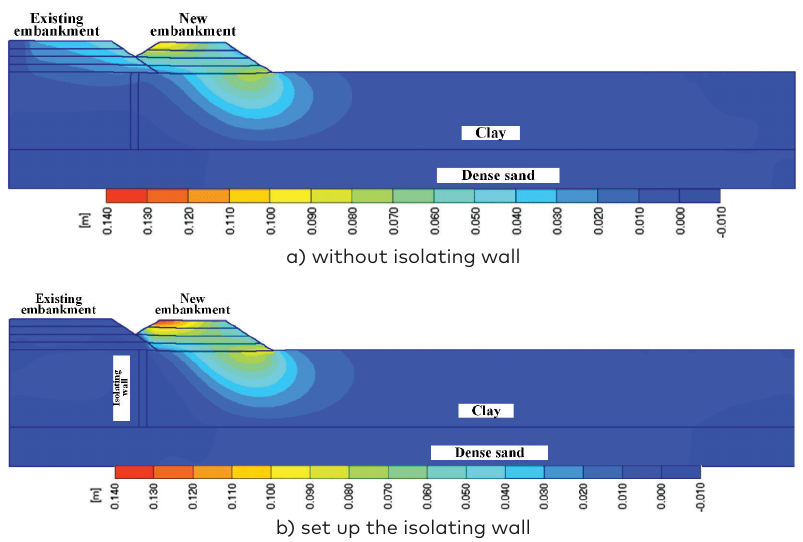
Figure 4. Lateral displacement distribution after 15 years of embankment